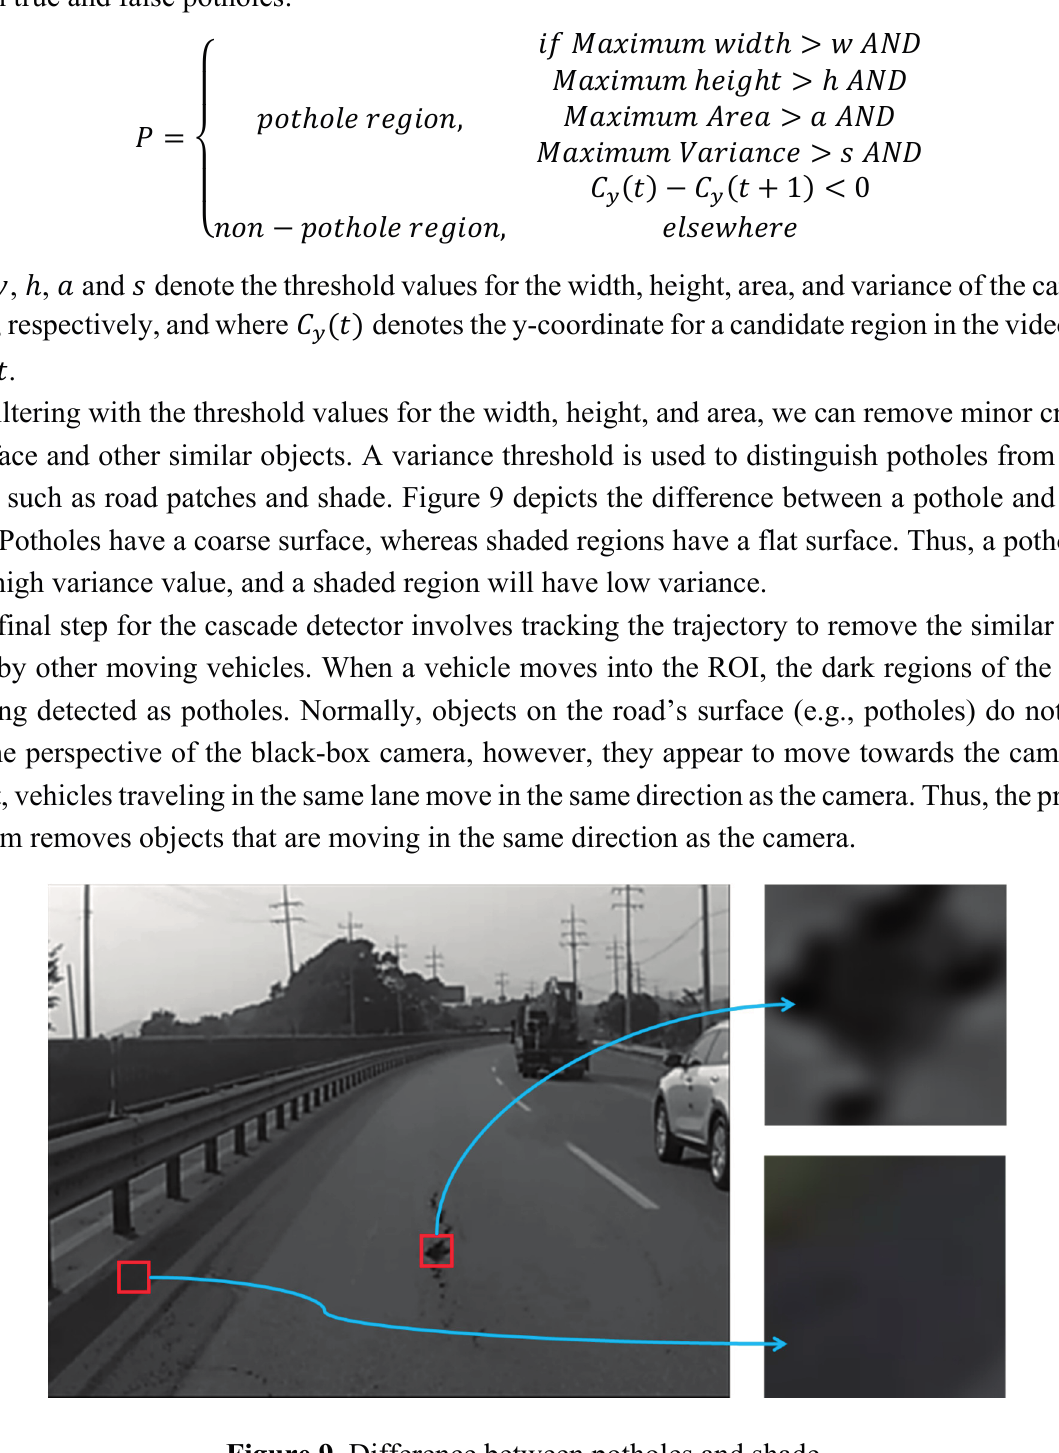
Figure 9. Difference between potholes and